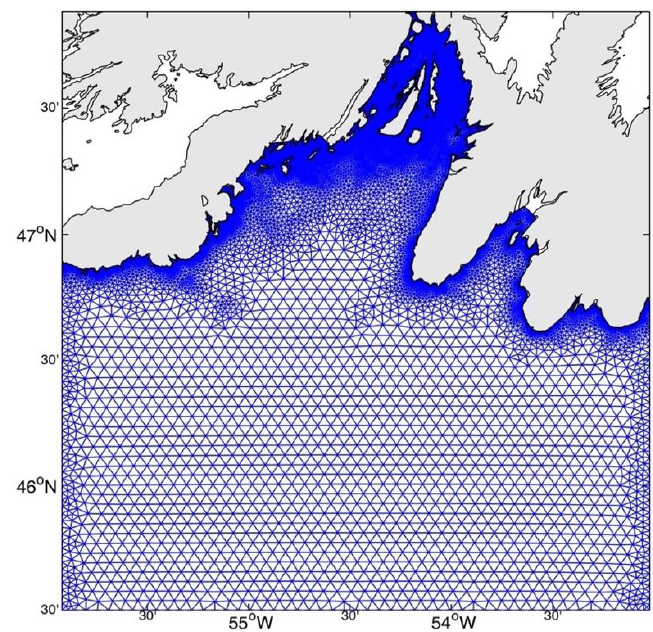
Figure 2. A model mesh with 25,414 nodes and 47,629 elements for Placentia Bay and adjacent shelf waters.